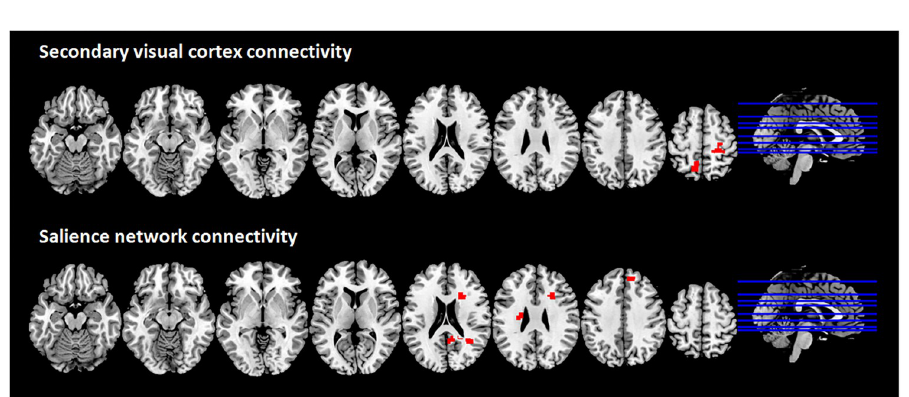
Fig 2. Brain regions showing increased functional connectivity with the secondary visual cortex and the salience network in the CBS patient compared to C-CBS group; multislice view of the regions overlaid on the MNI template; topological non-parametric correction at cluster-mass p -FWE < 0.05 and primary threshold p - uncorrected < 0.001.